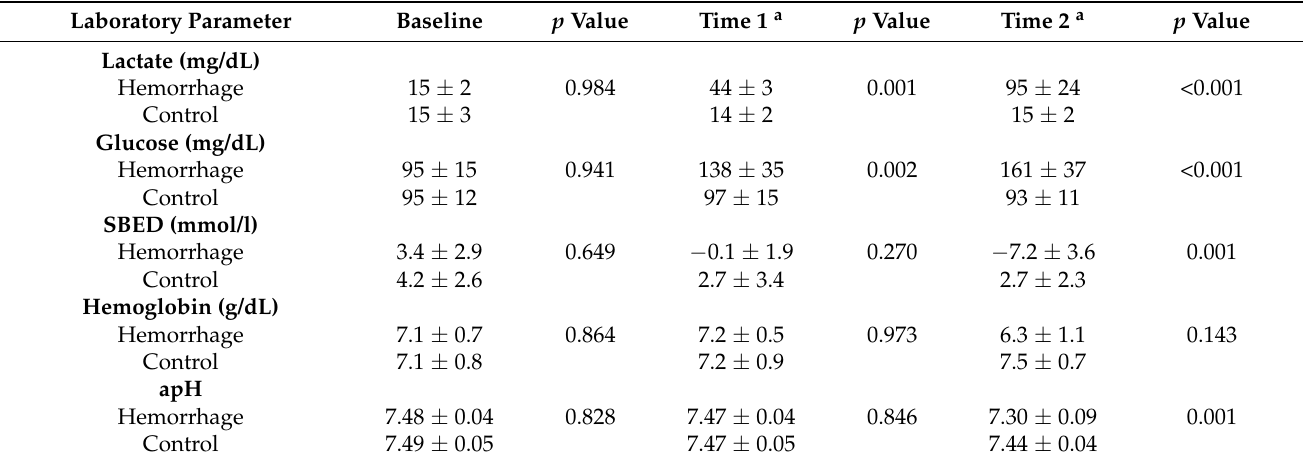
Table 1. Early and late laboratory indicators in acute hemorrhagic